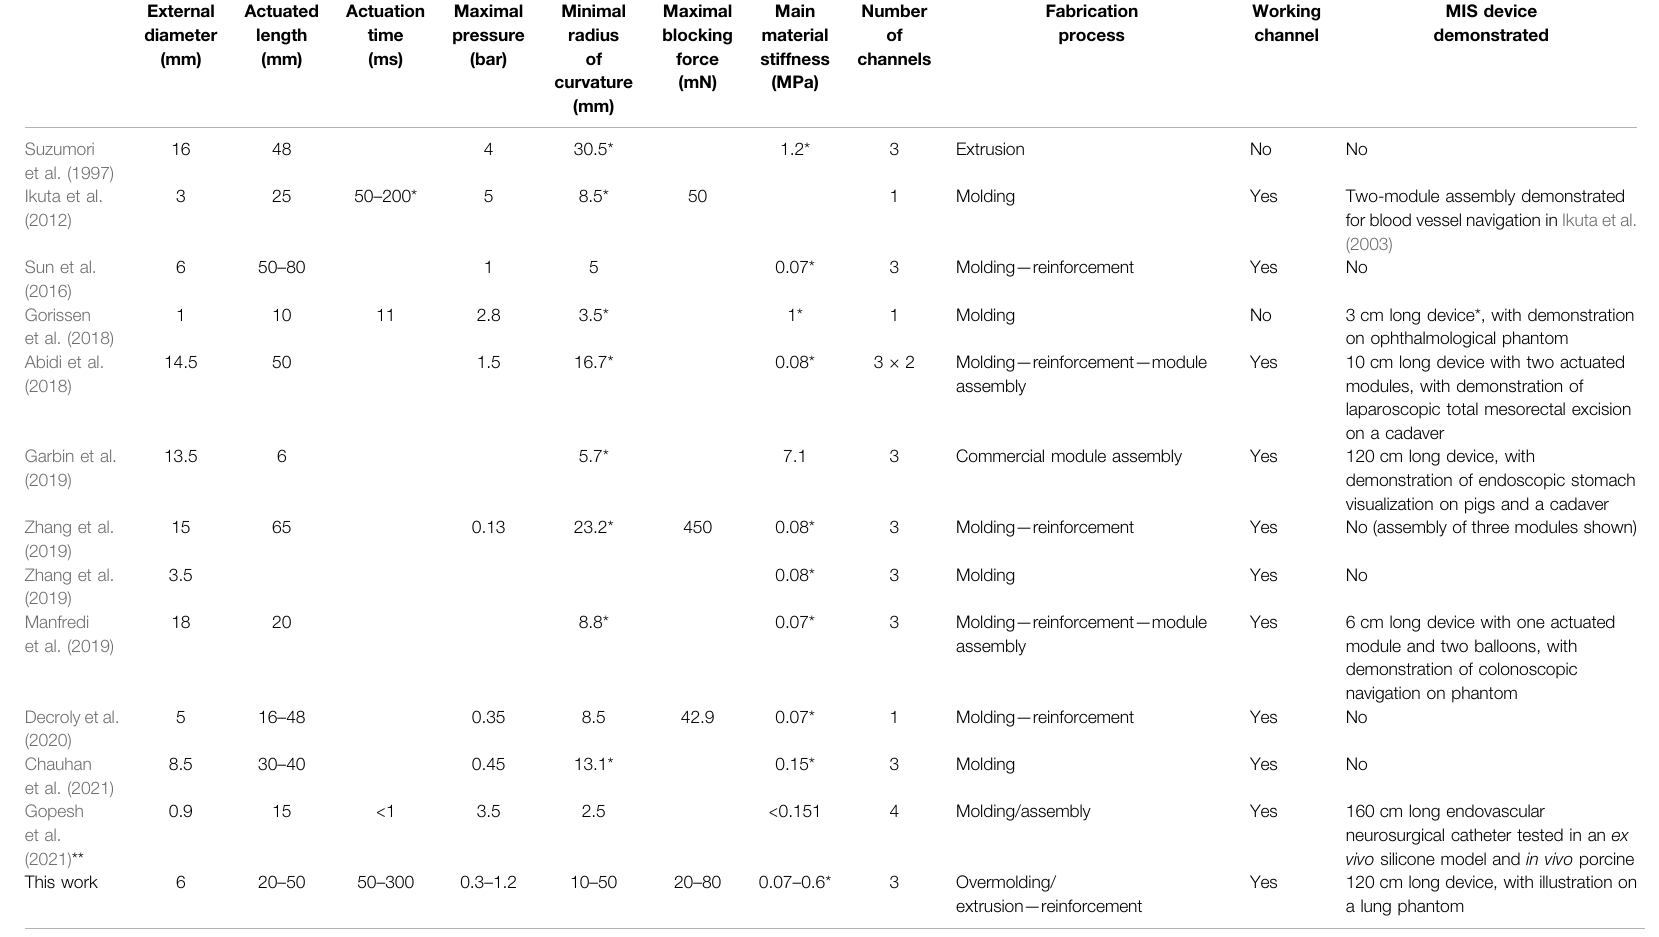
TABLE 2 | Comparison of pneumatic actuators for MIS and